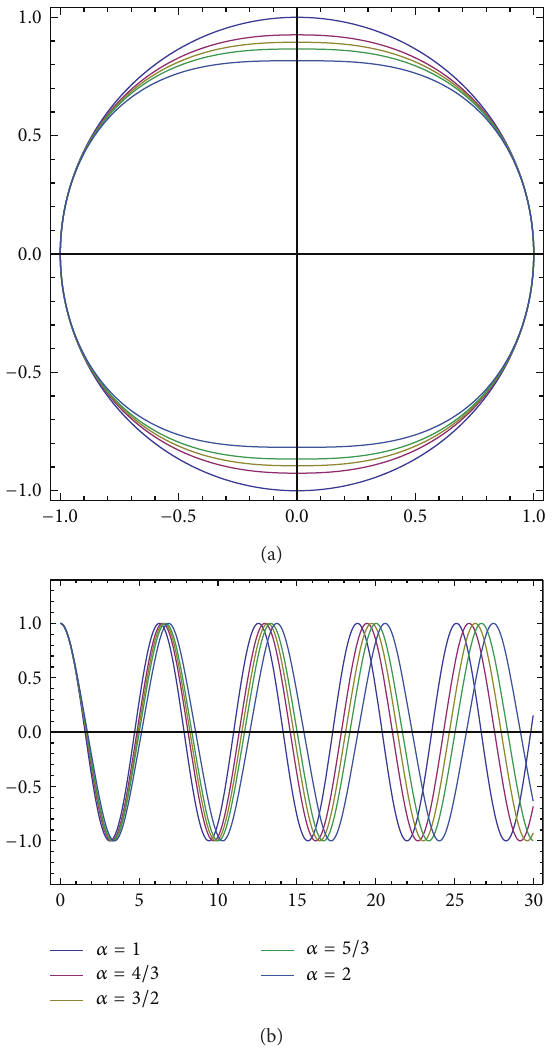
Figure 3: (a) Comparison for the 𝑢 versus ̇𝑢 trajectory for the case of 𝐴 = 1 and (b) 𝑡 versus 𝑢 (displacement 𝐴 = 1